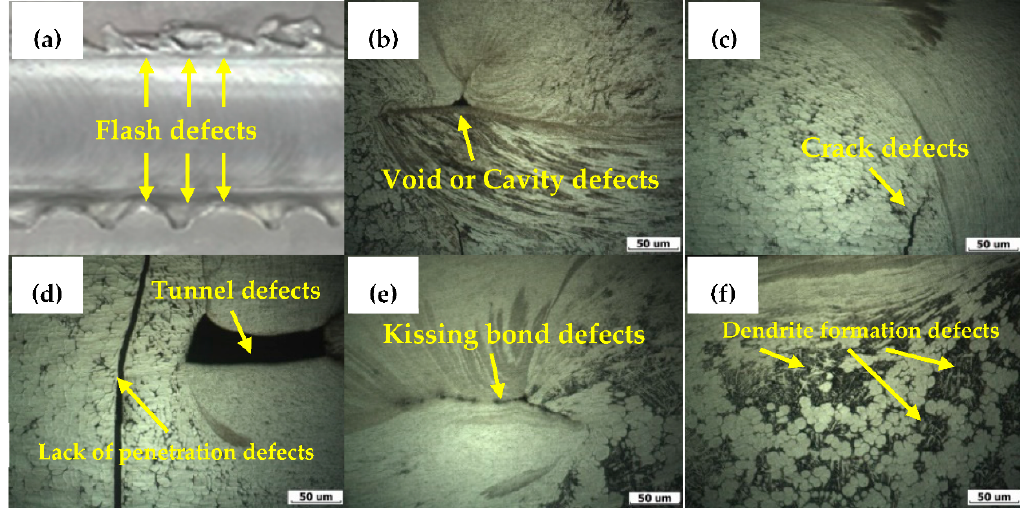
Figure 9. The six patterns of the defects of SSM 6063 aluminum alloy after FSWp in many different conditions for this experiment: ( a ) the flash defects, ( b ) the void or cavity defects, ( c ) the crack defects, ( d ) lack of penetration and tunnel defects, ( e ) the kissing bond defects, and ( f ) the dendrite formation defects.